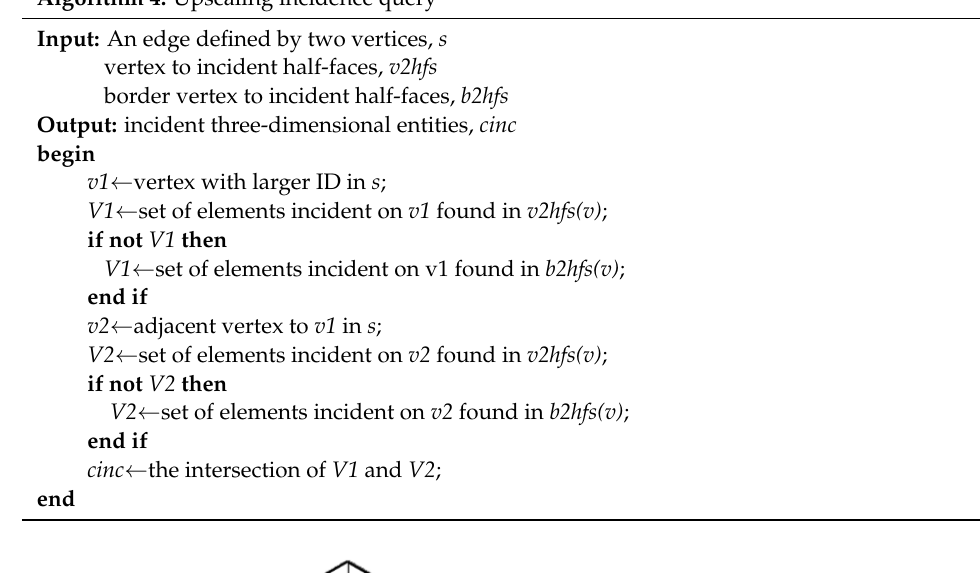
Algorithm 4: Upscaling incidence query